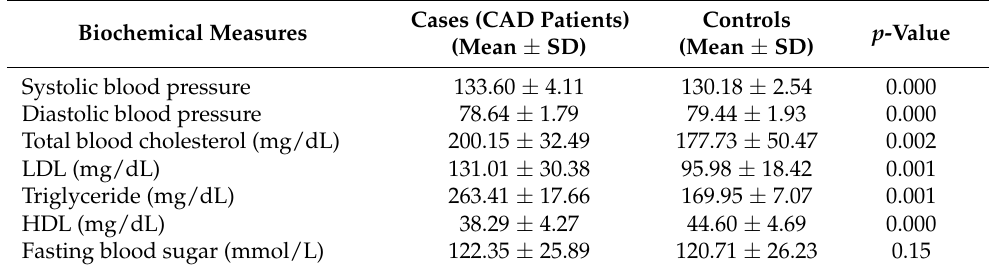
Table 2. Biochemical parameters associated with risk of CAD among patients and controls ( n = 500).